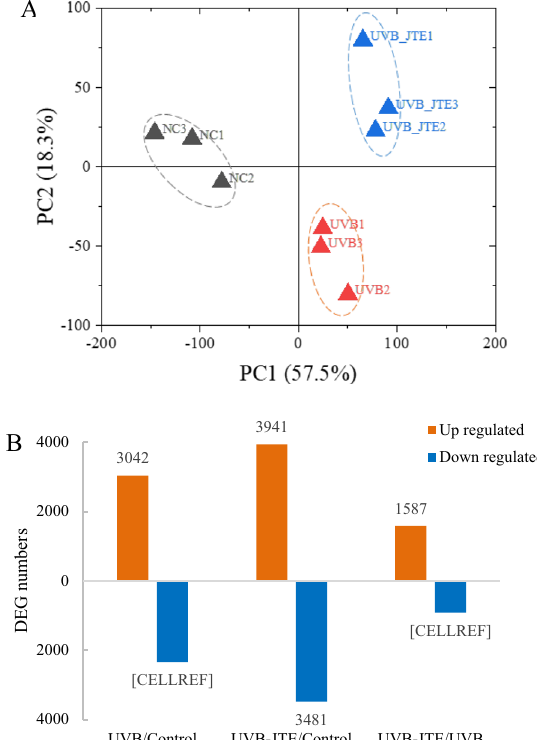
Fig. 3 PCA analysis of identified genes ( A ) and The DEG numbers ( B ) in different